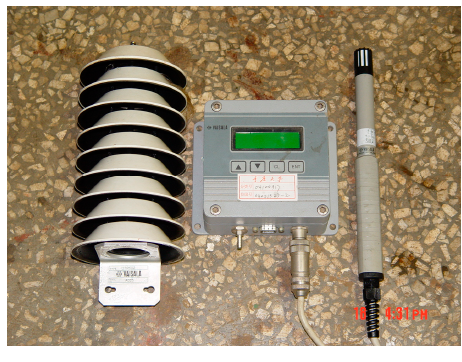
Figure 4. PTU2000.